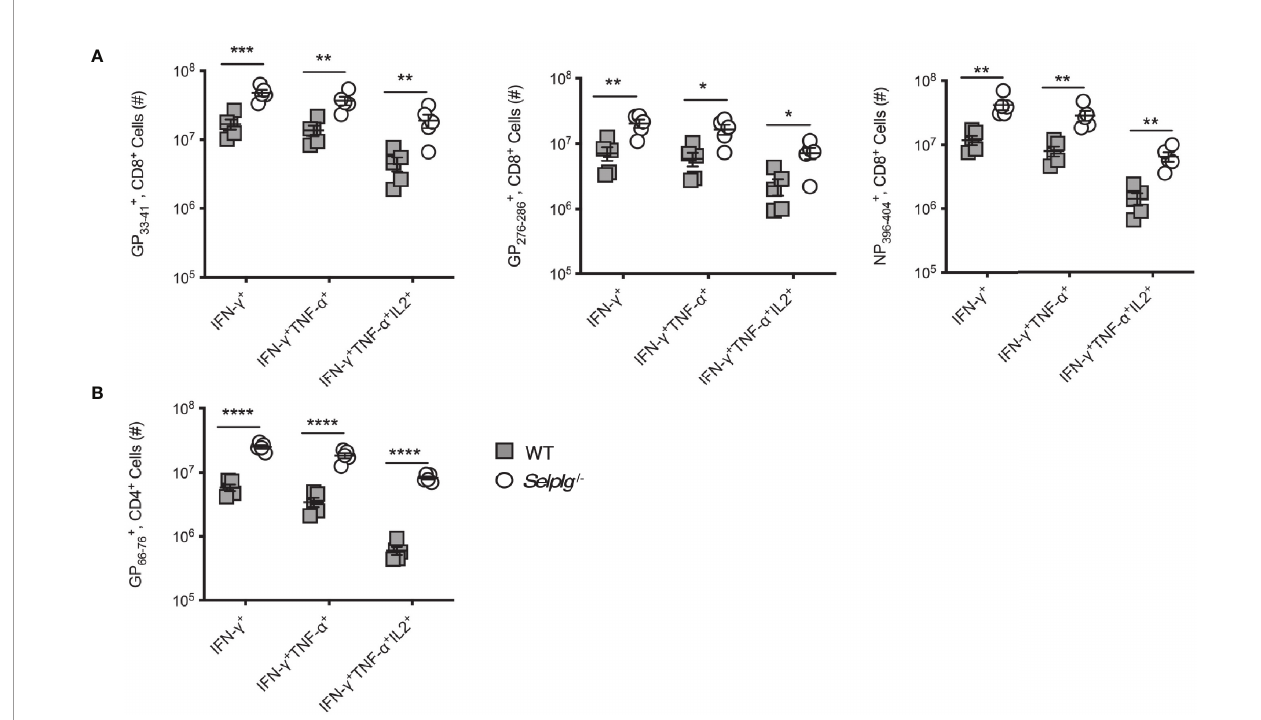
FIGURE 5 | Selplg -/- mice have increased accumulation of cytokine producing memory T cells. WT and Selplg -/- mice were infected with LCMV Armstrong and the spleens were isolated at 30dpi. Splenocytes were stimulated with the indicated viral peptides and the numbers of cytokine + CD8 + T cells (A) and CD4 + T cells (B) were enumerated. Data are representative of three independent experiments (n = 5 or more mice/group). Graphs show the mean ± SEM * p < 0.05, ** p < 0.005, *** p < 0.001, **** p < 0.0001 by two-tailed unpaired t-